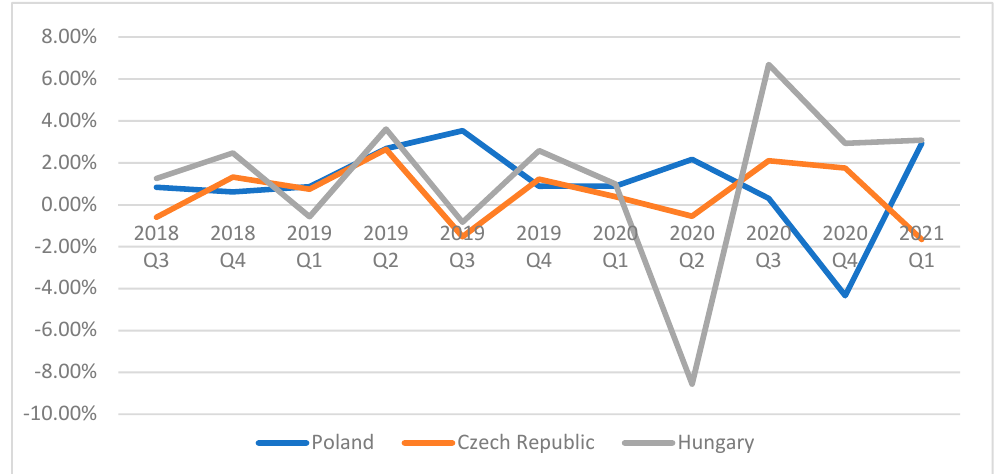
Figure 2 . Job vacancy rate in selected CEE countries . Source: (Eurostat Database 2021).